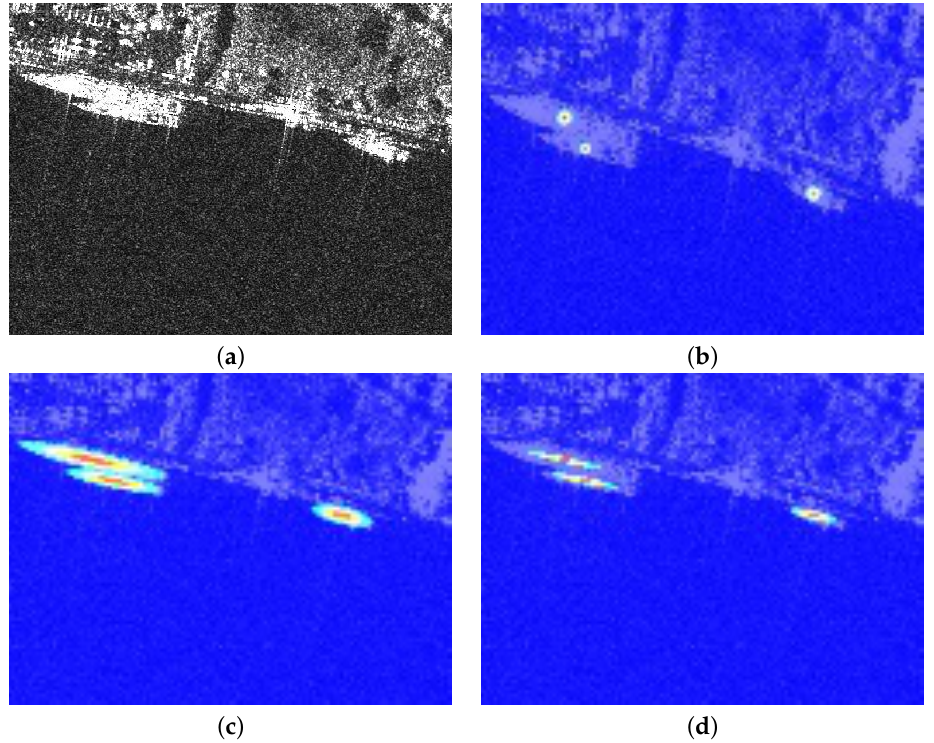
Figure 8. Heatmap instance: ( a ) SAR ship image; ( b ) circular Gaussian kernel; ( c ) elliptical Gaussian kernel; ( d ) multiscale elliptical Gaussian